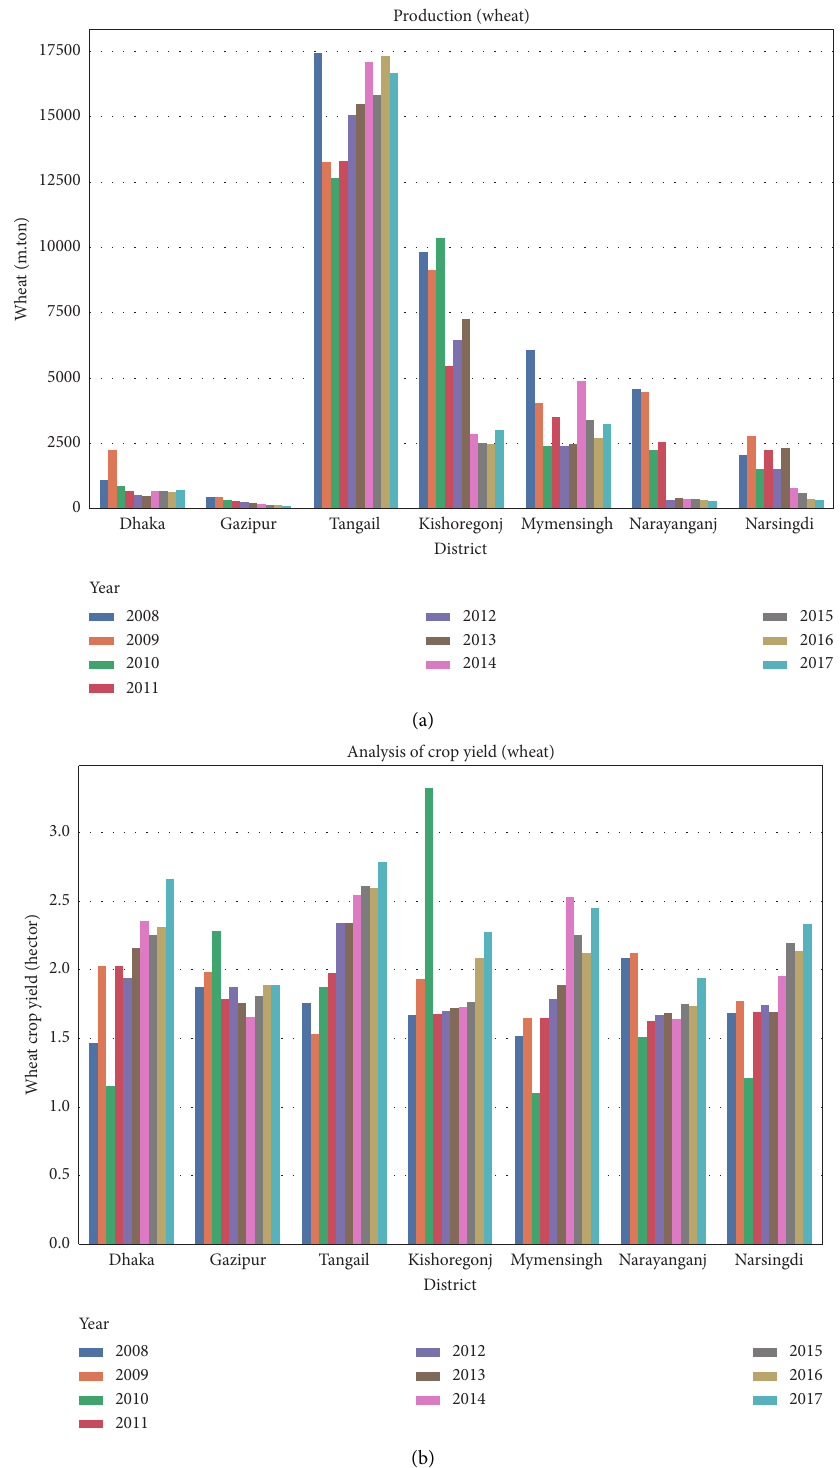
Figure 9: Data analysis of wheat. (a) Crop production for wheat. (b) Crop yield for